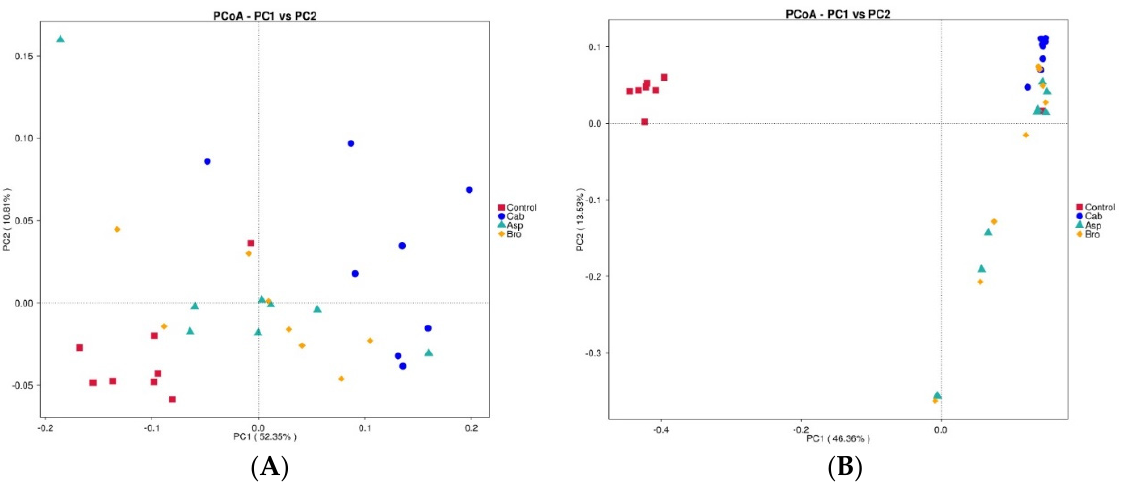
Figure 3. Correlation analysis diagram of intestinal flora species in each group of mice. ( A ) PCoA diagram of a certain angle; ( B ) PCoA diagram of another angle.